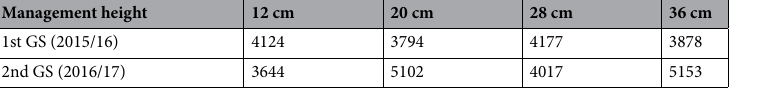
Table 1. Forage production (kg DM ha −1 year −1 ) in a Highland grassland dominated by Andropogon lateralis Nees and managed under different canopy heights and intermittent stocking grazing in two growing seasons (GS). Mean = 4236 kg DM ha −1 year −1 and SEM = 1434 kg DM ha −1 year −1